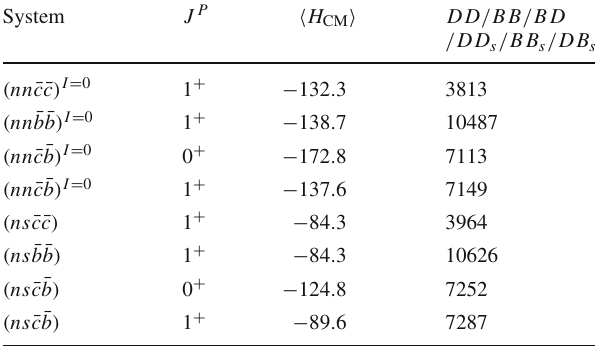
Table 10 Numerical results (units: MeV) for the systems containing light “good” diquark only. The tetraquark masses in the last column are estimated with the thresholds of DD / BB / BD / DD s / BB s / DB